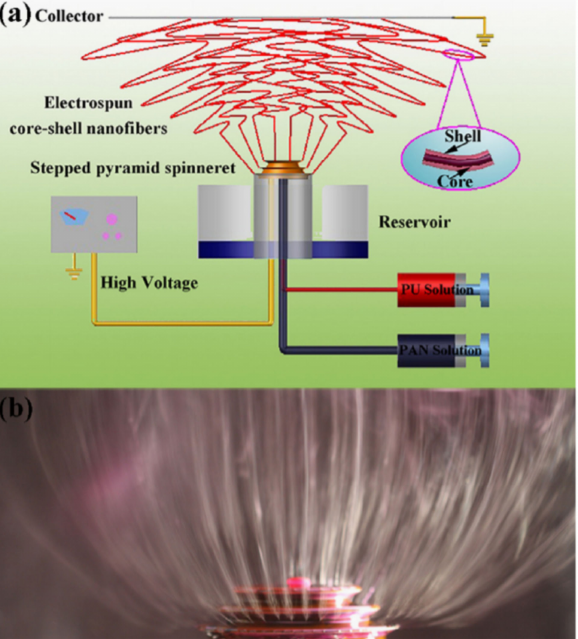
Figure 34. ( a ) Scheme of free coaxial electrospinning apparatus using a stepped pyramid spin- neret; ( b ) a picture of coaxial jets in electrospinning process. Reprinted with permission from [370]. Copyright 2014